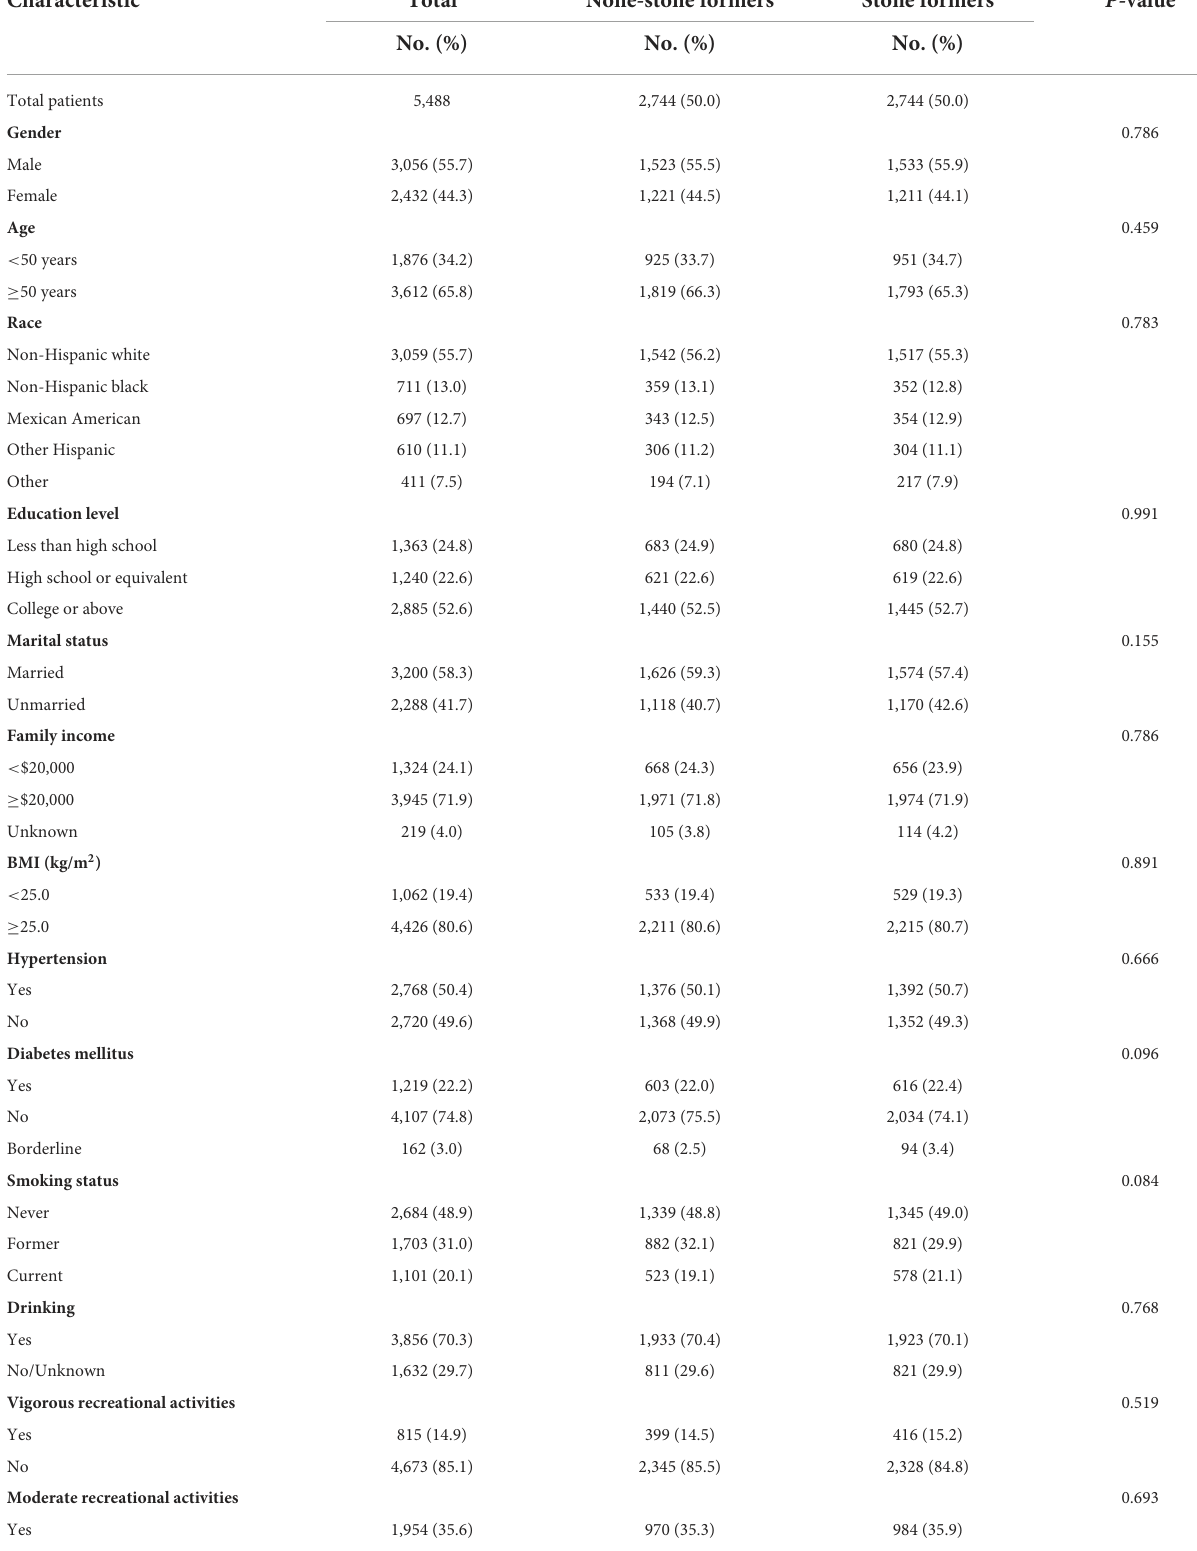
TABLE 3 Baseline characteristics of NHANES participants between 2007 and 2018 after PSM.